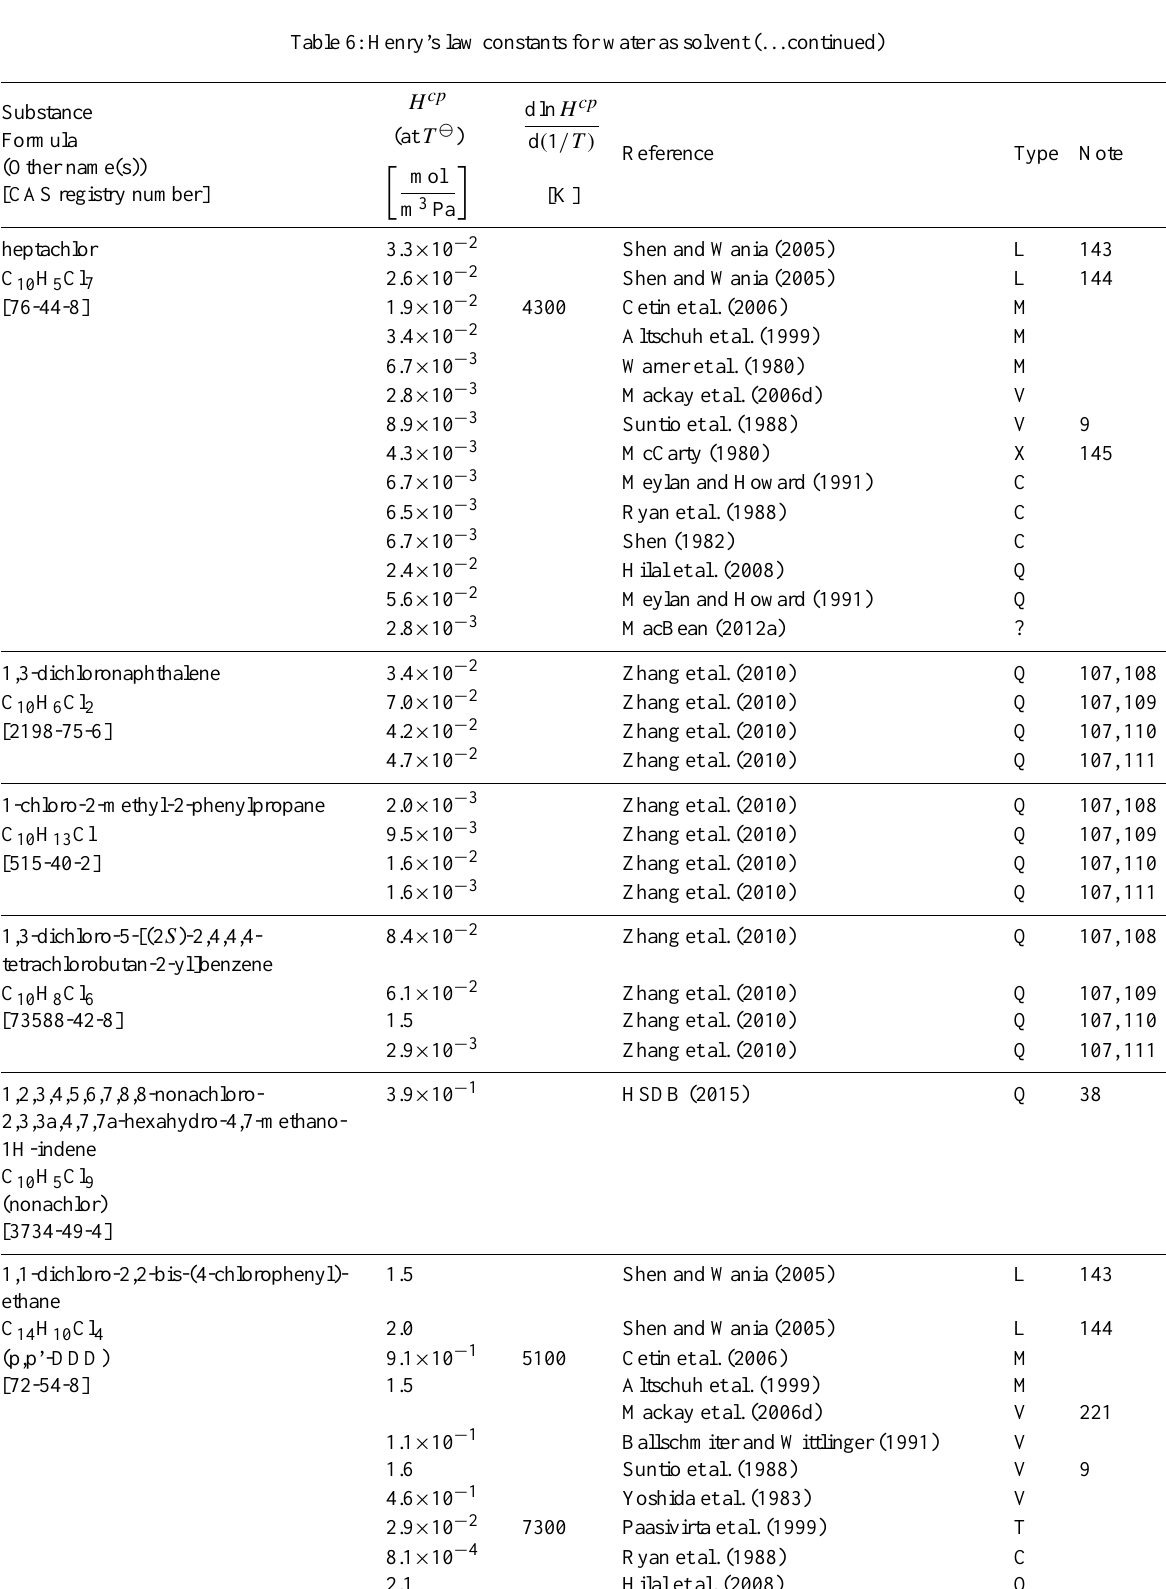
Table 6: Henry’s law constants for water as solvent